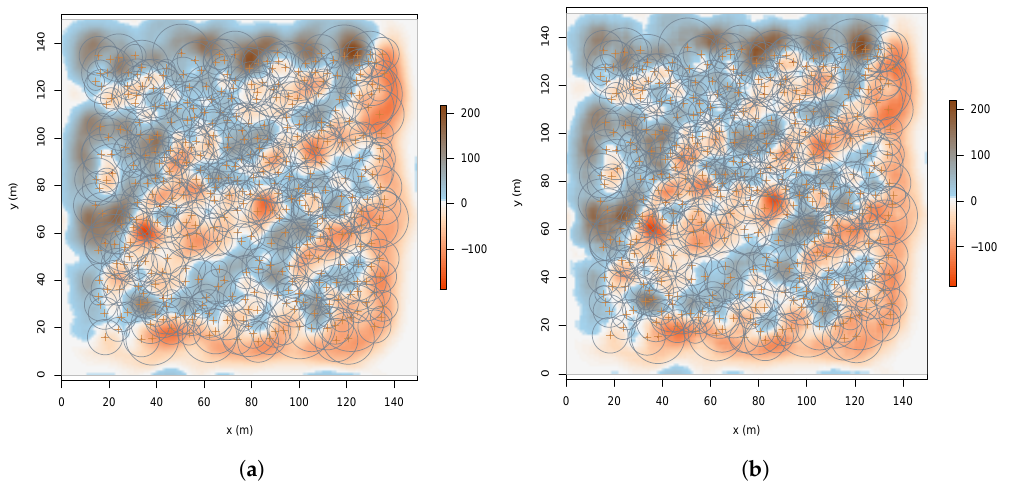
= 8 m showing the close agreement 4